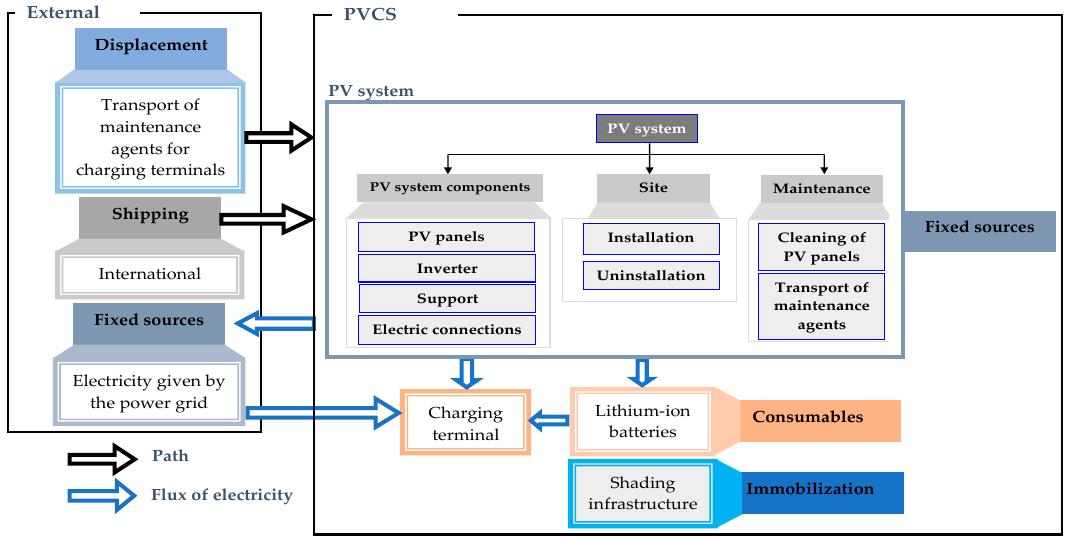
Figure 1. Perimeter of the